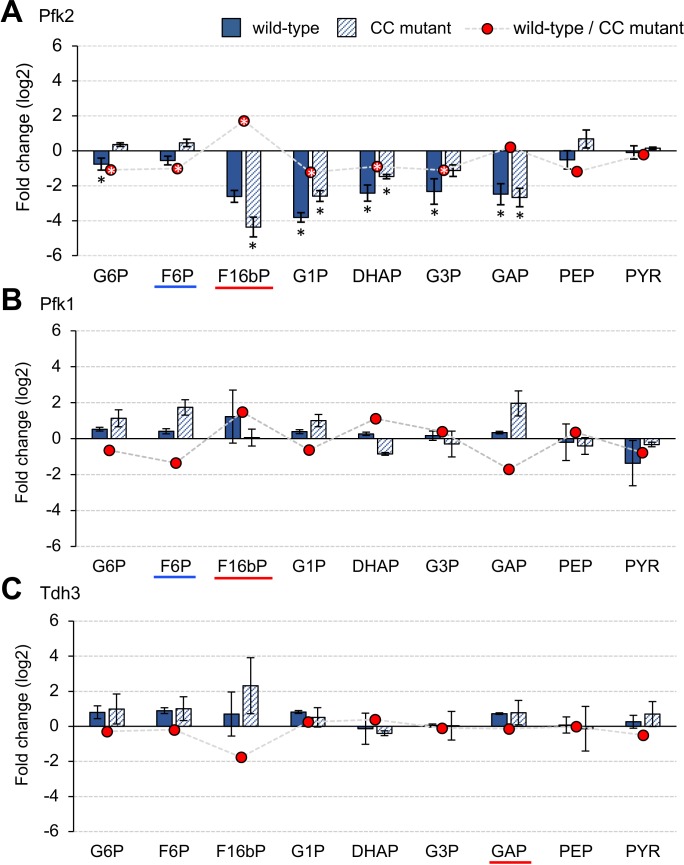
Metabolic changes triggered by overexpression of glycolytic proteins in vivo.(A–C) The bar graph shows the log2-fold change in each metabolite in the cells overexpressing wild-type and mutant Pfk2, Pfk1, and Tdh3 over the vector controls. The red circle shows the log2 fold-difference in each metabolite between the wild-type and the CC mutant measurements. The metabolites were measured in exponentially growing cells cultured in low-copy conditions. The error bars indicates the standard deviations of the mean for three (Pfk2) and two (Pfk1, Tdh3) biological replicates. *p<0.05 in Welch's t-test.10.7554/eLife.34595.018Figure 5—source data 1.This spreadsheet contains all data and statistical values associated with the figure.